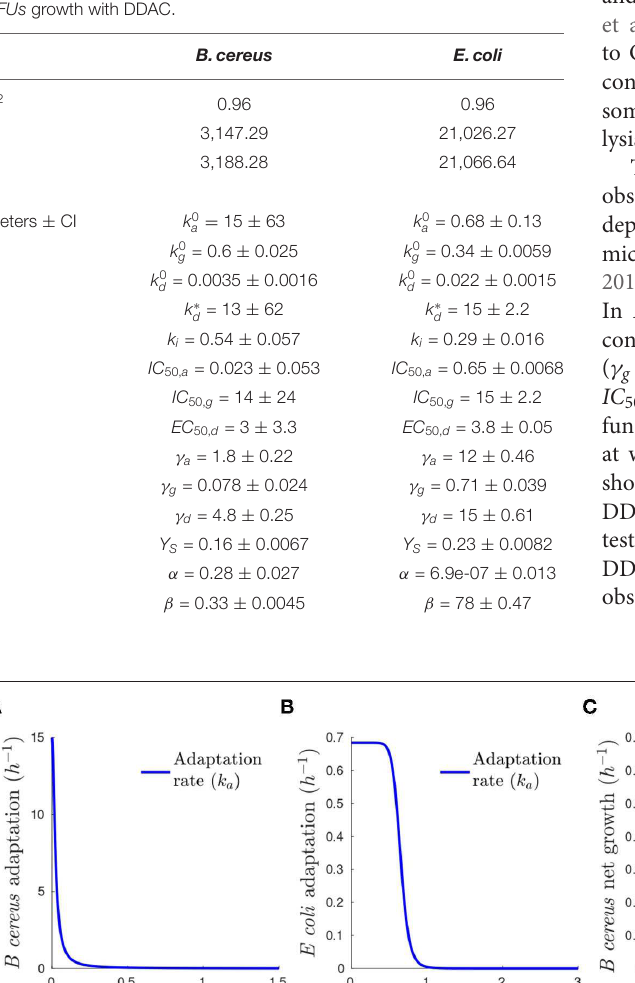
TABLE 4 | Results (performance indexes and estimated parameters with their confidence intervals) for the extended mechanistic model to account for both OD and CFUs growth with DDAC.